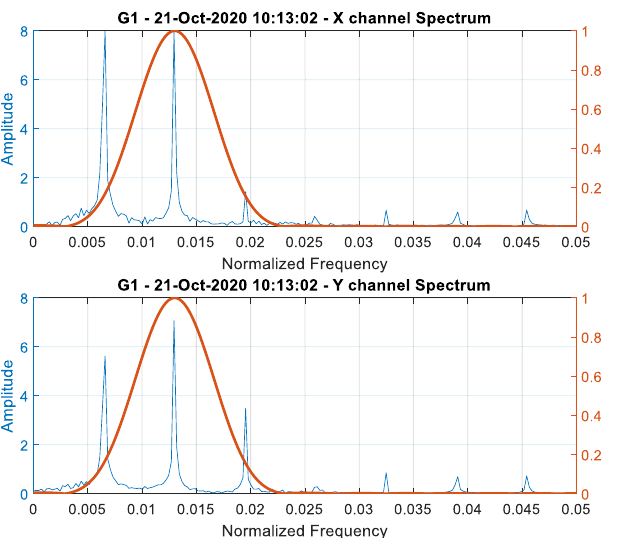
Fig. 13. Time evolution of the PCA estimates of R , e and # on real signal from Signayes HGU (nominal, regimated condition). In blue the 1 (cid:4) orbit, in red the 2 (cid:4)